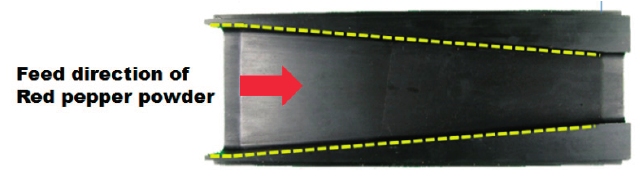
Figure 6. A photo of the powder surface leveler used to shape the surface evenly.